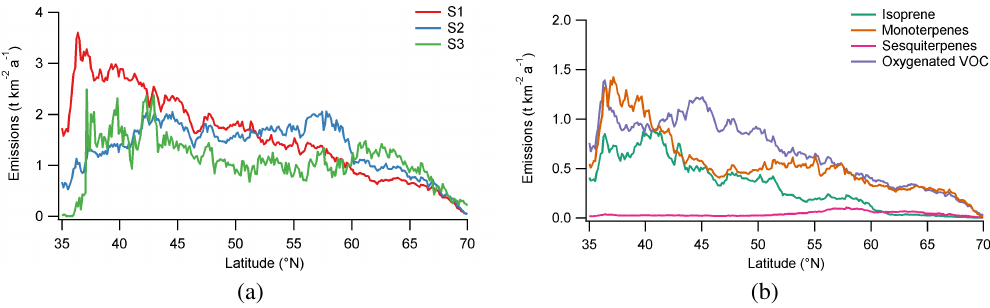
Fig. 6. Variation of annual emissions of 2006 for the original countries with latitude for the inventories (a) and variation of emissions of individual compounds in the S1 inventory with latitude (b).